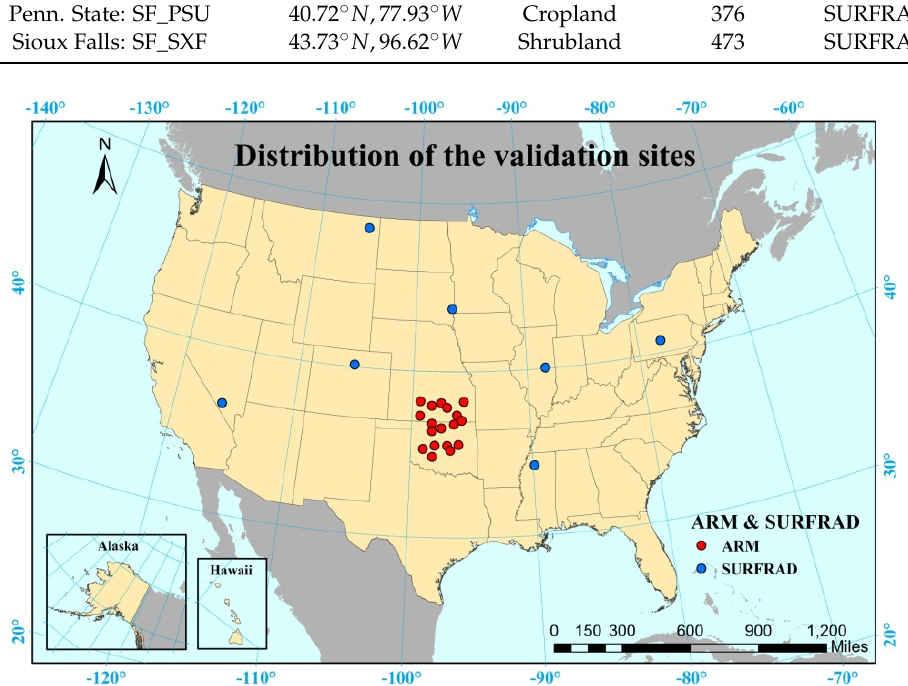
Figure 1. Distribution of the 25 validation sites in the United States.